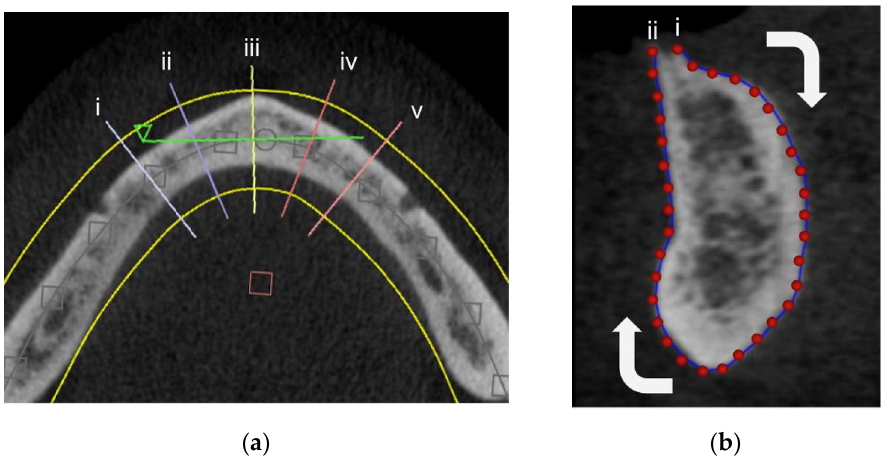
Figure 1. Two-dimensional digitization. ( a ) Interforaminal cross sections in the axial view for (i,ii,iv,v) paramedian sections and (iii) a symphysis section. ( b ) Curve digitization in tpsDig: (i) starting point and (ii) end point.